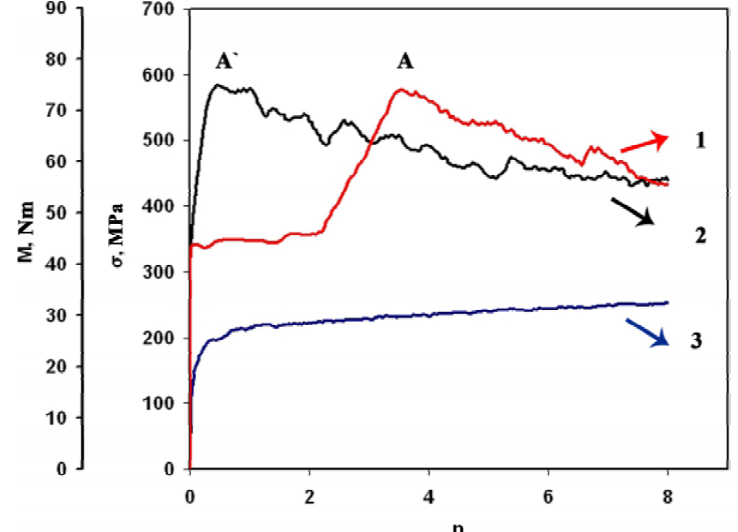
Fig. 2. Dependence of Ì(n) and s (n) during HPT at 293K: 1 - initial crystalline Ti amorphous Ti